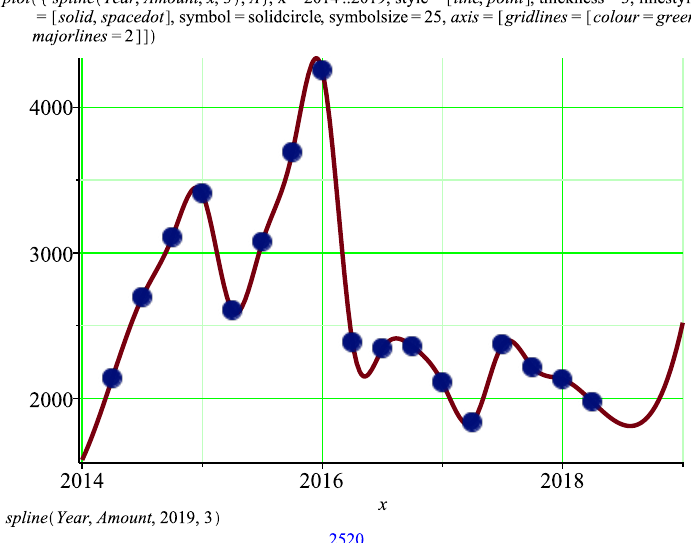
Figure 5. Graphical interpretation in the Maple system of the forecasting of Ukrainian emigrants number